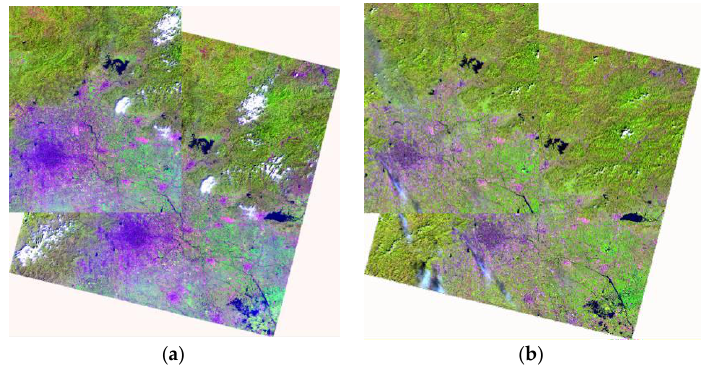
Figure 2. Cropped images extracted from a 2013/2015 TM false-color pair. ( a ) Scene 1 (31 July 2013); ( b ) Scene 2 (7 September